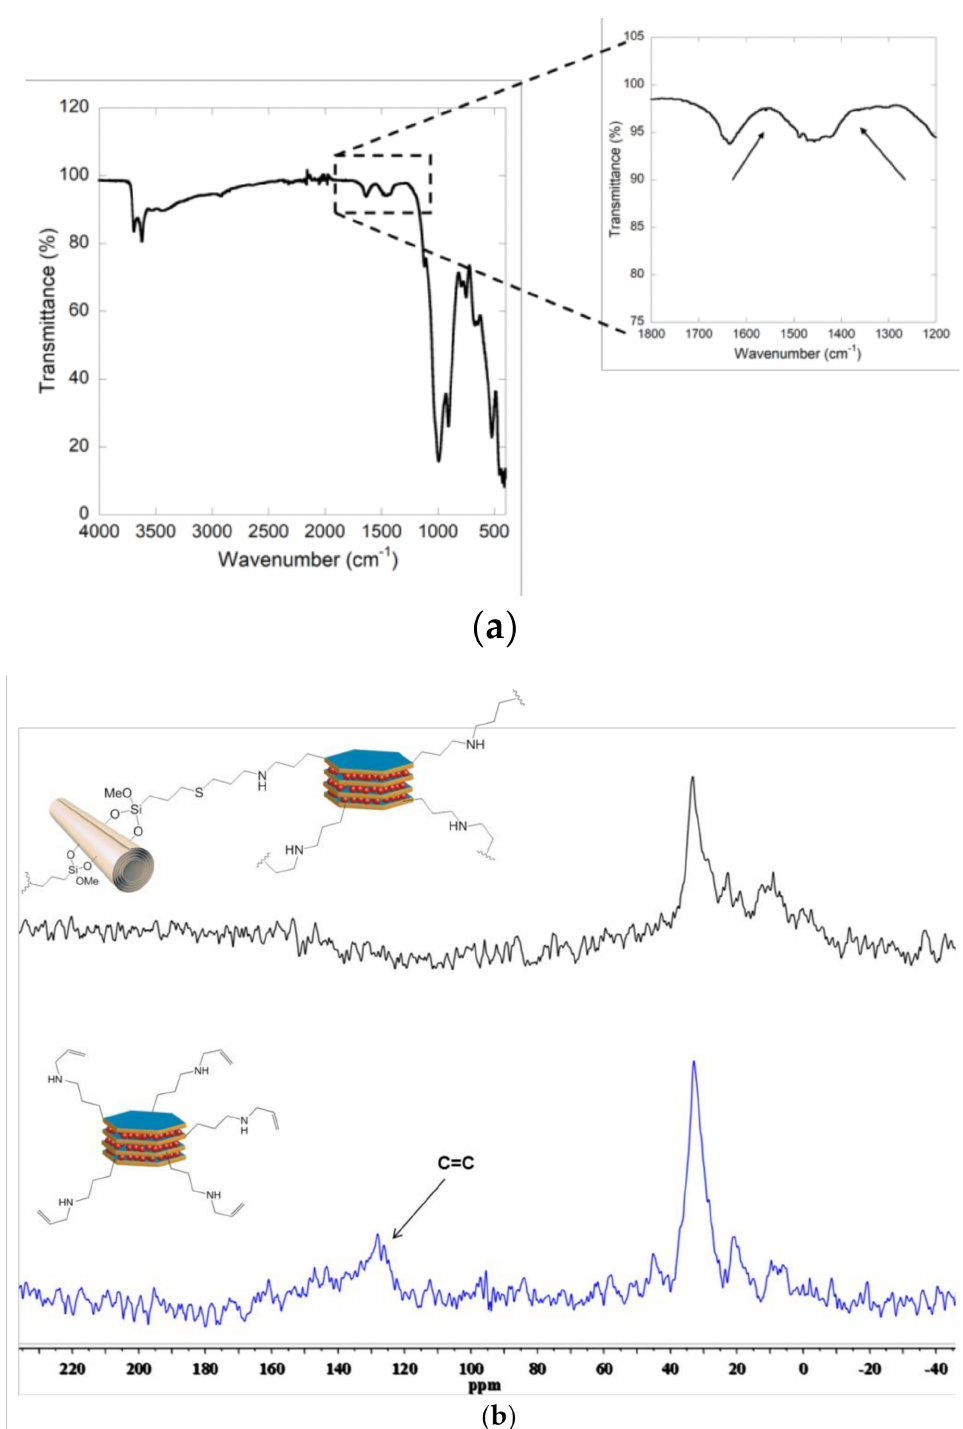
Figure 2. ( a ) FTIR spectrum of HNTs-Ht nanomaterial; ( b ) solid state 13 C NMR spectra of Ht-Allyl (blue line) and Hal-Ht (black line)